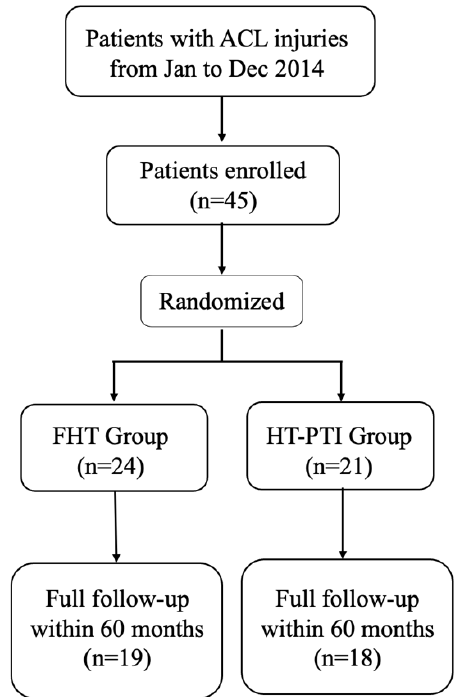
Figure 1. Flowchart of the randomized clinical trial. Full follow-up within 60 months included patients who had follow-up at pre-operation and 6, 12, 24, and 60 months postoperatively. The HT-PTI group had ACLR with an insertion preserved hamstring tendon autograft, and the FHT group had ACLR with a free hamstring tendon autograft. HT-PTI, hamstring tendon with intact tibial insertion; FHT, free hamstring tendon; ACL, anterior cruciate ligament; ACLR, ACL reconstruction.